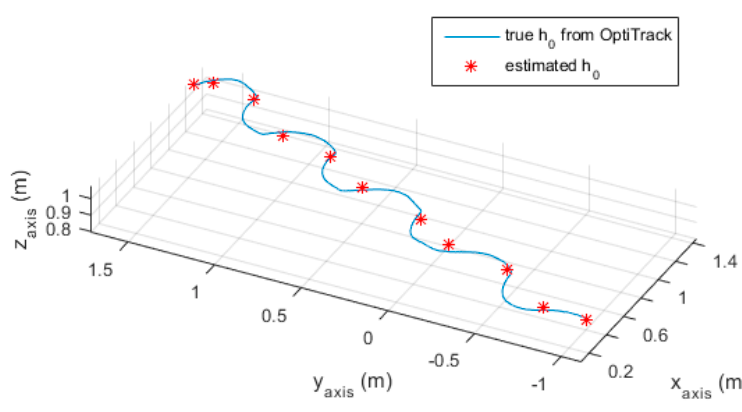
Figure 13. System pointing angle estimation example.